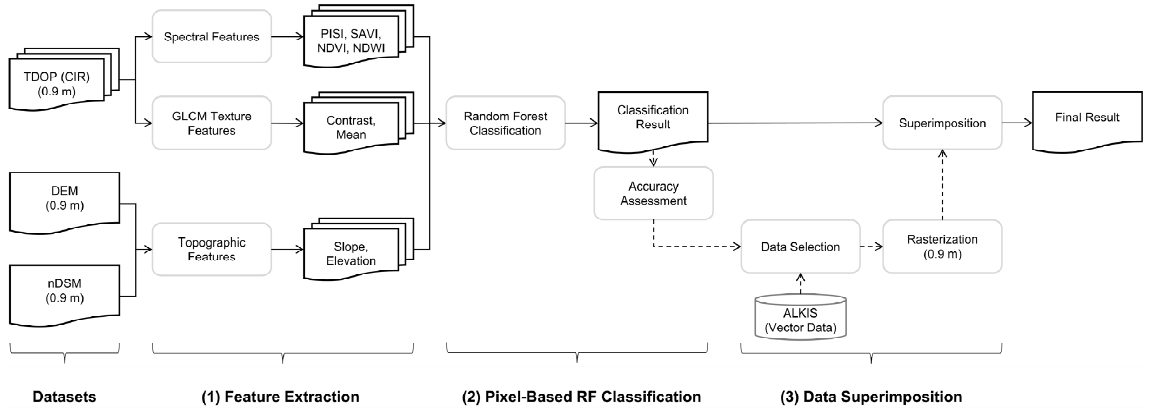
Figure 2. Conceptual workflow outlining the proposed methodology. The methodology is structured in three major steps feature extraction (1), pixel-based RF classification (2) and data superimposition (3).